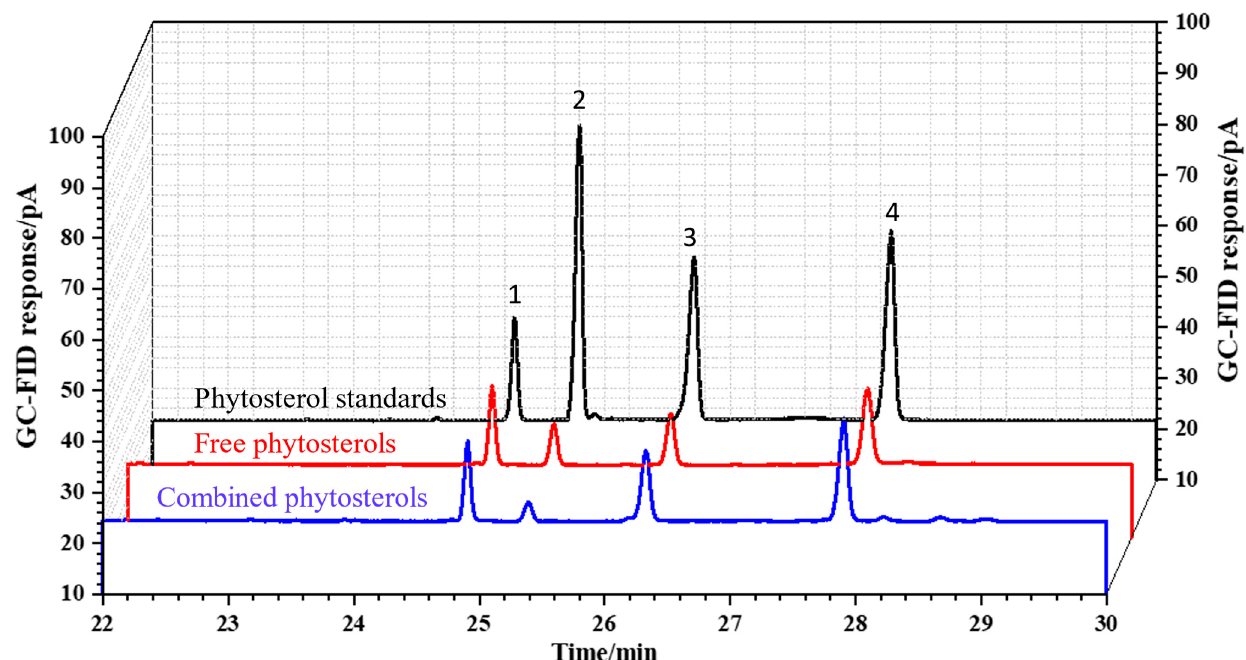
Figure 3. GC chromatogram for analysis of phytosterol standards (black line), and free/combined phytosterols in rapeseed oil after separation by SPE: free phytosterols in rapeseed oil (red line) and combined phytosterols (after saponification) in rapeseed oil (blue line). Peak 1, β -cholestanol; Peak 2, brassicasterol; Peak 3, campesterol; Peak 4, β -sitosterol.